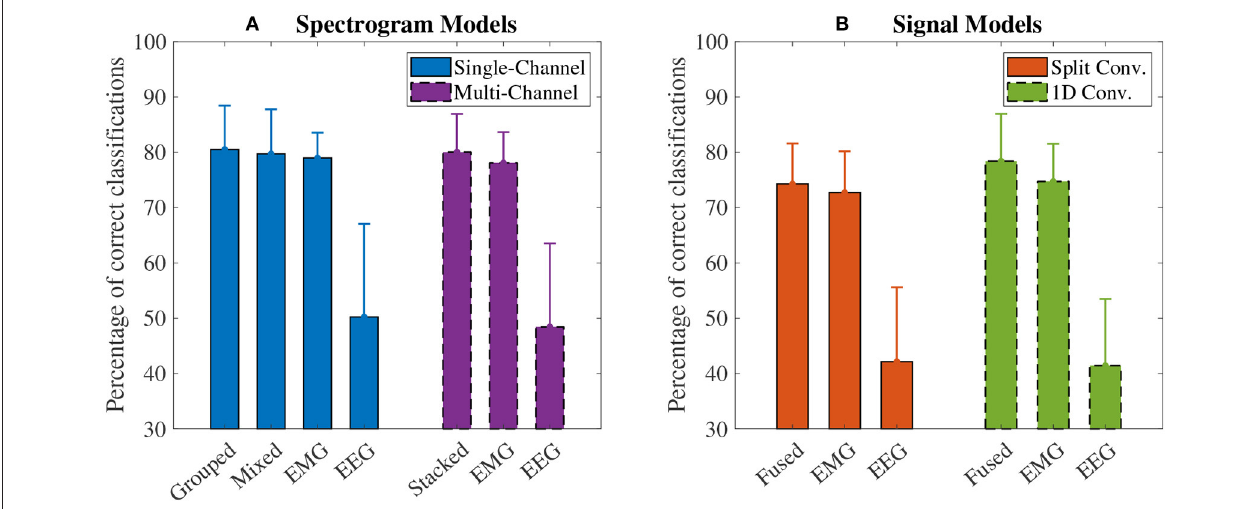
FIGURE 7 | The mean accuracy of all (A) spectrogram and (B) signal based CNN models, calculated across both speeds and all task weights. Error bars represent one standard deviation. Note that the y axis begins at 30% (chance level for these models is